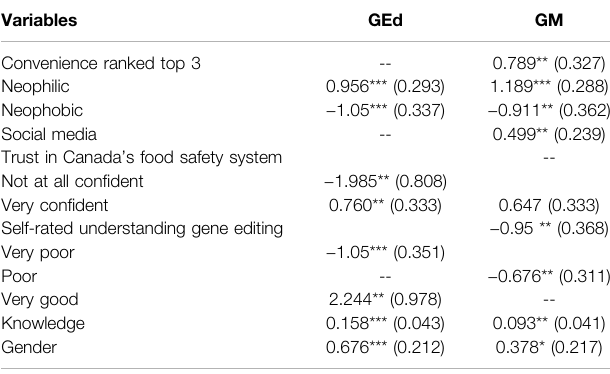
TABLE 4 | Parameters estimated for Ordered Logit Model. Variables Convenience ranked top